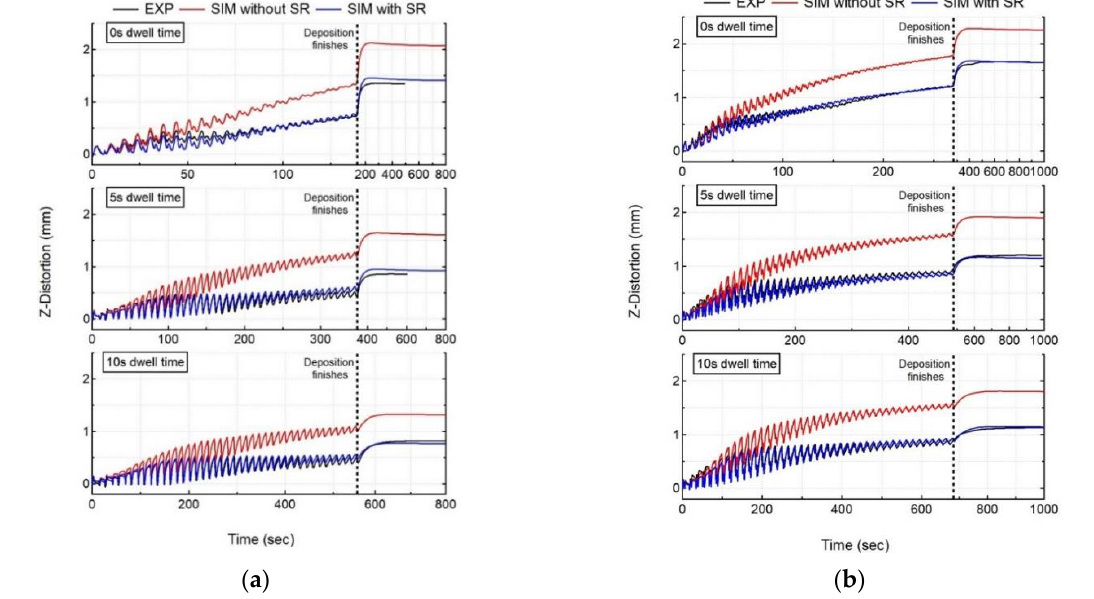
Figure 8. Comparison of numerical results (SIM with and without stress relaxation (SR)) with recorded in situ distortion accumulation of LDS (EXP) for all cases ( a ) single-bead wall, ( b ) double- bead wall.